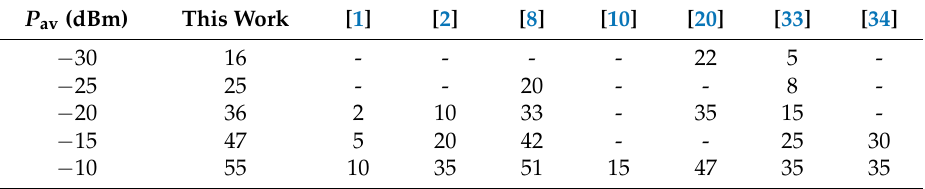
Table 4. Comparative of the rectenna efficiency (%) of this work with other papers with similar designs. P av